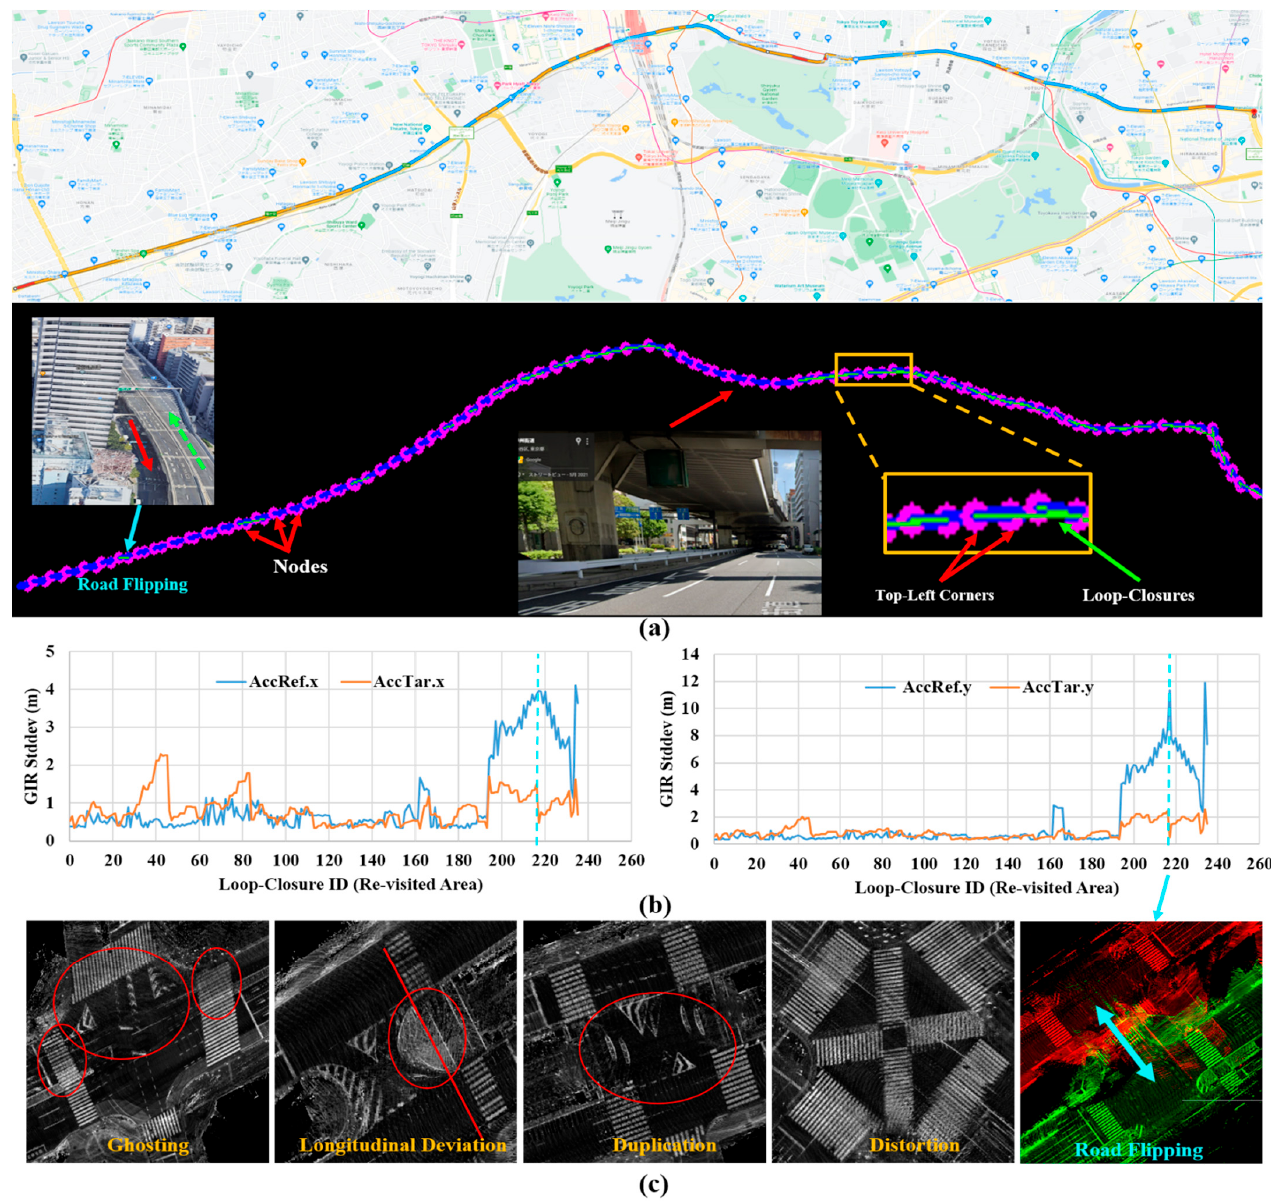
Figure 5. Driving under the bridge in two directions with surrounding high buildings. ( a ) The ve- hicle trajectory is represented by nodes with indicating loop closures by green links. ( b ) Accuracy profiles of the GIR system along the revisited areas (in two opposite lanes) in X and Y directions. ( c ) Different ghosting patterns in GIR map in lateral and longitudinal directions by flipping the road lanes at the most correct image.